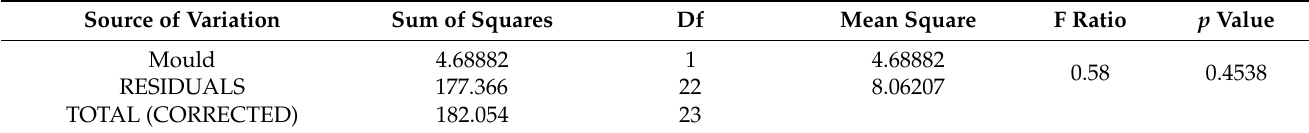
Table 13. ANOVA for ABS flexural strength (annealing temperature range 100–135 ◦ C).